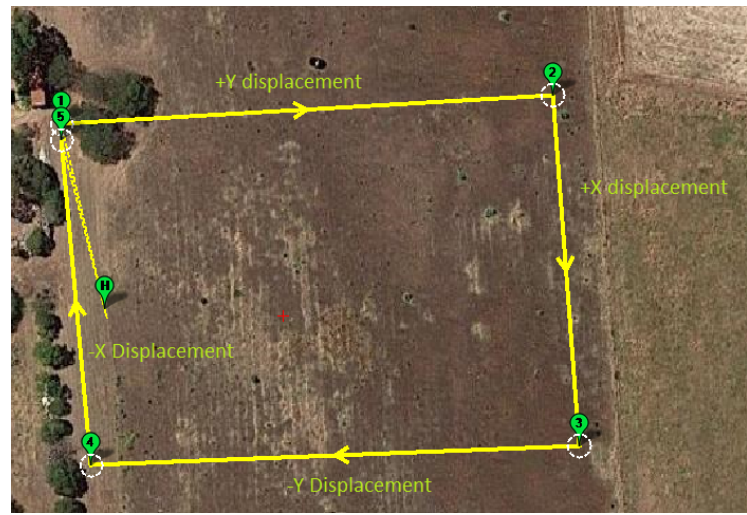
Figure 7. View of the environment of dataset 2 with its flight path in Mission Planner. The data were captured at two different thermal contrast conditions: during a clear sunny day in late Autumn at 1600 h with high contrast in thermal data, and during a foggy rainy day during winter at 0900 h, which yields low thermal contrast. Hence, dataset 2 contains two smaller subsets of the same field that can be used to evaluate the performance of thermal flow during high and low-contrast conditions. Figure 8 shows some of the thermal images of the site under both conditions.